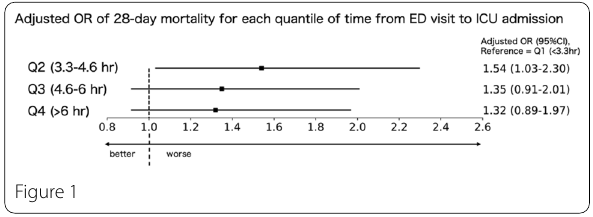
Results: We identified 2,188 eligible patients with sepsis. In the mul- tivariable analysis, time from ED visit to ICU admission was not sig-